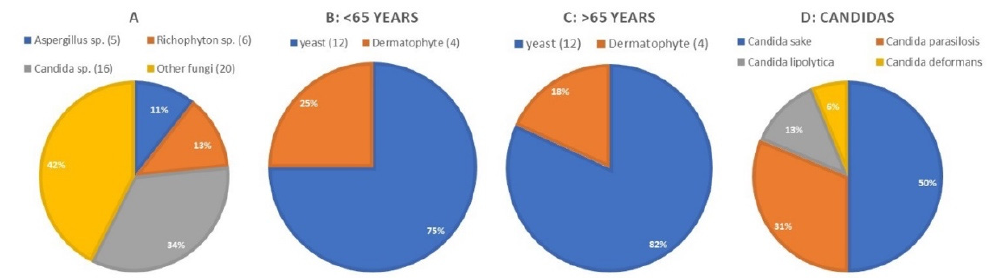
Figure 1. Details of the patterns of distribution of infecting agents. ( A ) Genera of fungi with the highest prevalence. ( B ) Dermatophytes and yeast in patients with less than 65 years. ( C ) Dermatophytes and yeast in patients over 65 years old. ( D ) Yeast species isolated.